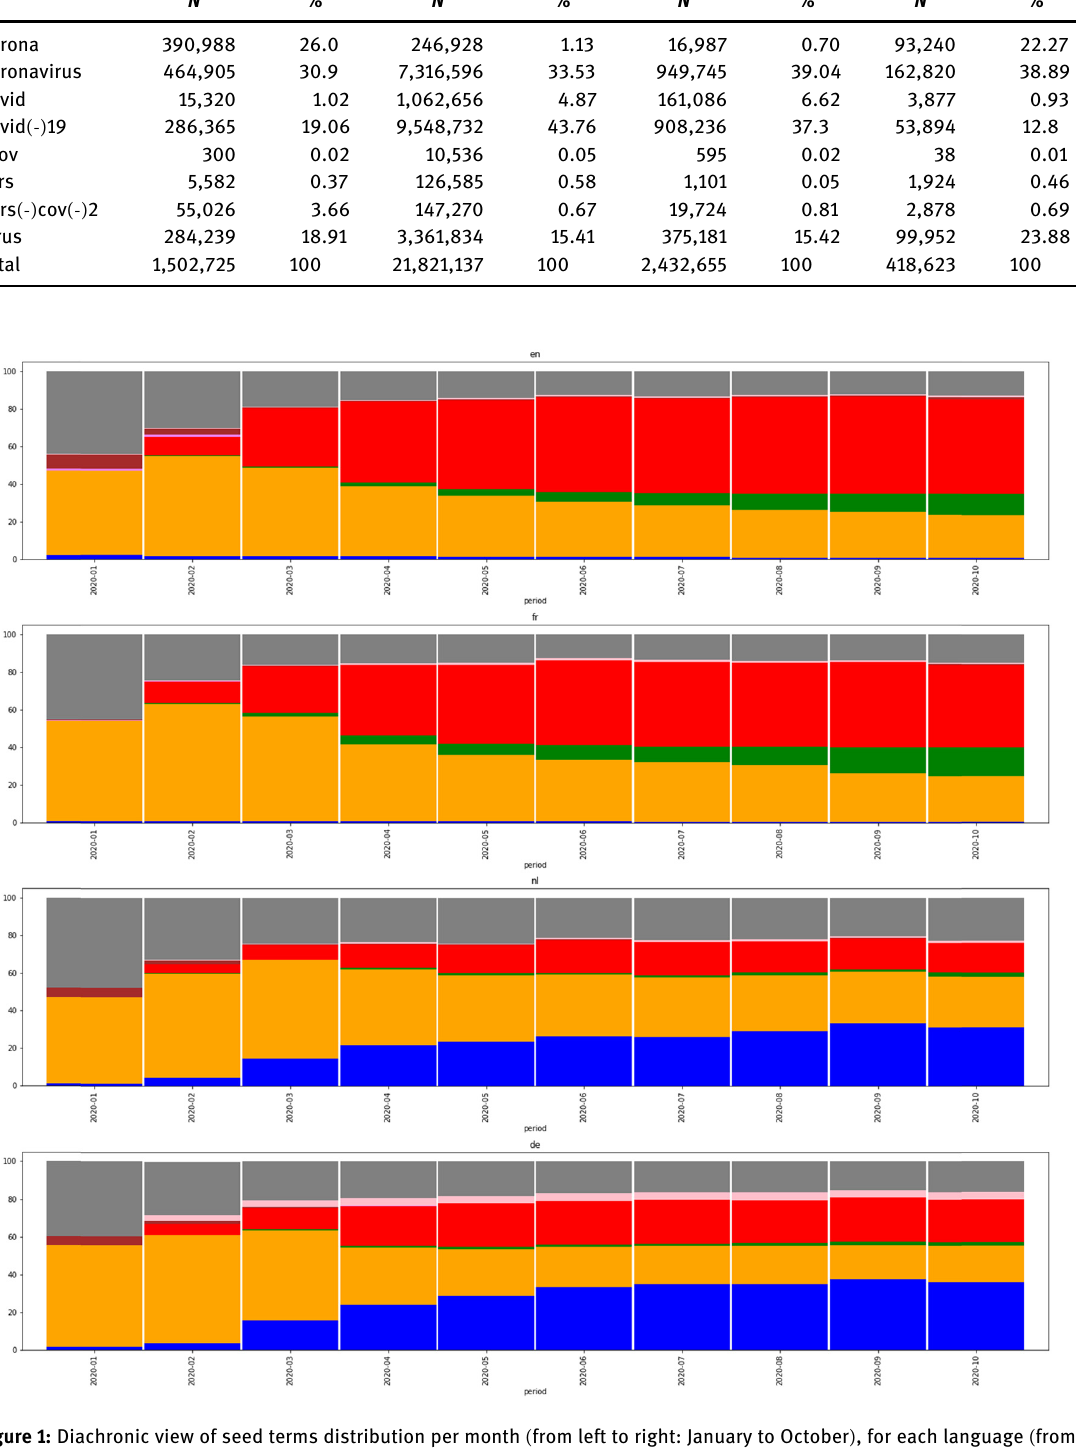
Figure 1: Diachronic view of seed terms distribution per month ( from left to right: January to October ) , for each language ( from top to bottom: English, French, Dutch, and German ) , expressed as a percentage ( calculated from the sum of absolute frequency per language per month [ color codes: blue = corona, orange = coronavirus, green = covid, red = covid - 19, violet = n - cov, brown = sars, pink = sars - cov - 2, grey = virus ])